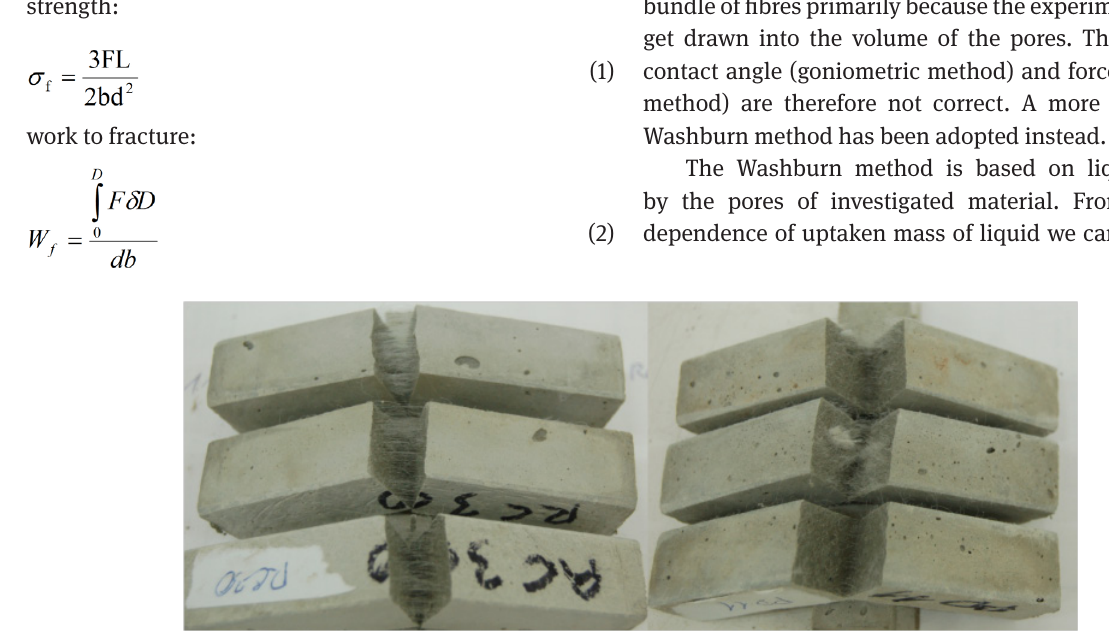
Figure 3: Concrete samples after three-point bending test of flexural